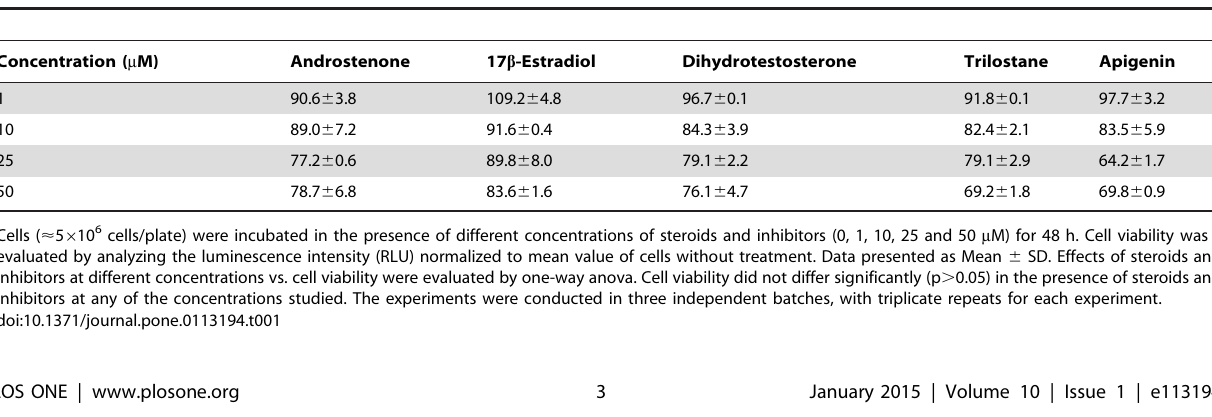
Table 1. Cytotoxicity of steroids and HSD inhibitors in isolated pig hepatocytes.